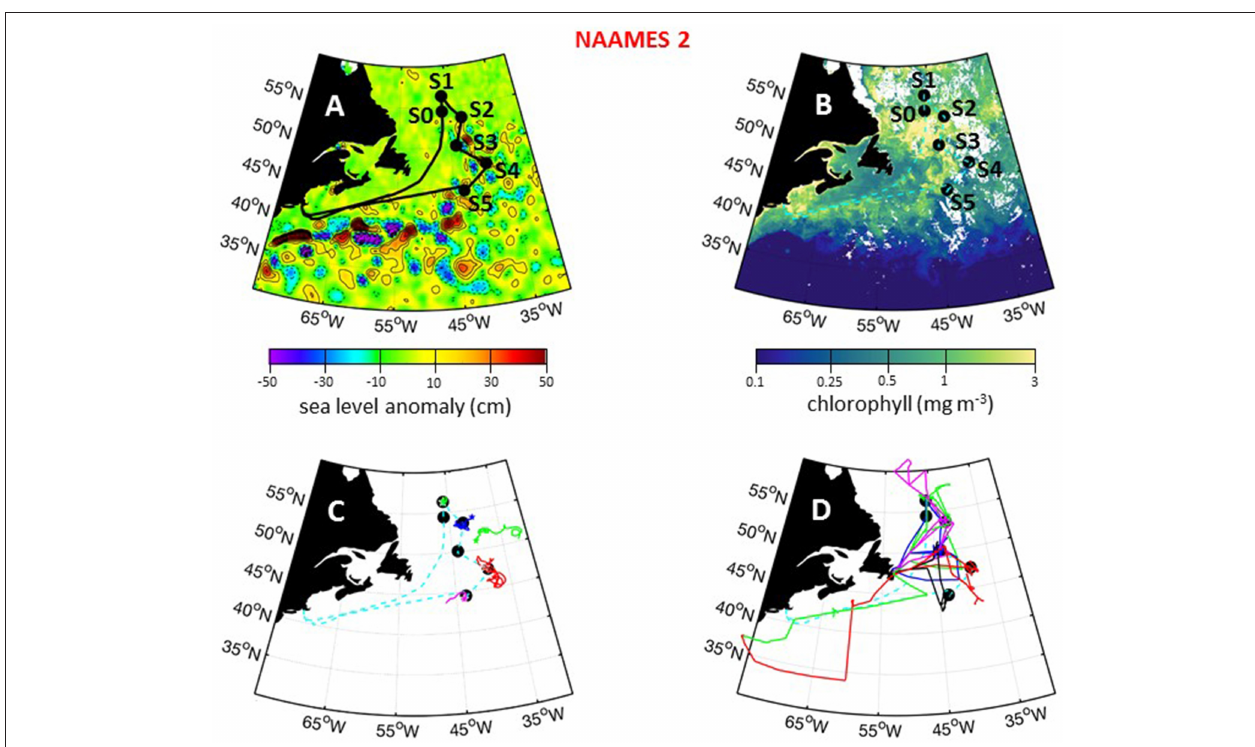
FIGURE 8 | NAAMES 2 primary stations, autonomous floats, and flight tracks. (A) Black line = ship transit. Labeled black circles = primary sampling stations. Background color = sea surface height anomalies highlighting anticyclonic and cyclonic mesoscale eddies in red and blue/purple, respectively. (B) Climatological surface chlorophyll concentrations for the NAAMES 2 period from satellite ocean color measurements. (C) Thirty-day trajectories for floats deployed during NAAMES 2 and 130 days for floats deployed before NAAMES 2. Star = float deployment site. (D) C-130 flight paths for the NAAMES 2 airborne campaign. Broken cyan line in (B–D) = ship